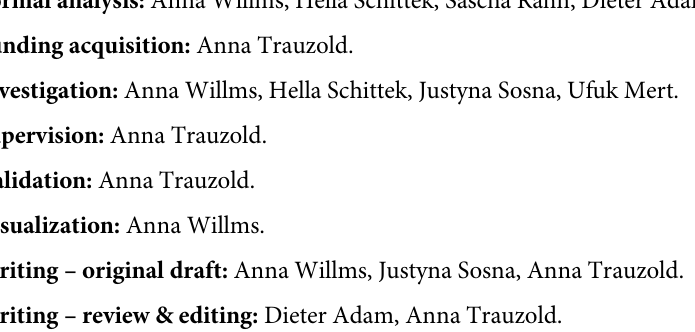
S2 Fig. RKO p53 +/+ and p53 -/- cells are resistant to TRAIL-R-mediated cell death. RKO p53 +/+ and RKO p53 -/- cells were stimulated either with TRAIL (200 ng/ml), Mapatumumab (10 μ g/ml) or Lexatumumab (10 μ g/ml) for 24 h with or without zVAD-fmk (20 μ M). Cell via- bility was determined by crystal violet staining (A). Results are shown ± SD of three biological replicates (n = 3). (TIF) S3 Fig. Impact of p53 status on TRAIL-R-mediated non-apoptotic signaling pathways in RKO cells. RKO p53 +/+ and RKO p53 -/- cells were stimulated either with TRAIL (200 ng/ml), Mapatumumab (10 μ g/ml) or Lexatumumab (10 μ g/ml) for 3 h. Whole cell lysates were ana- lyzed for the phosphorylation/activity status and overall expression of various proteins associ- ated with TRAIL-mediated non-apoptotic signaling pathways by Western blot (A). Blots are shown for one representative experiment out of three performed.